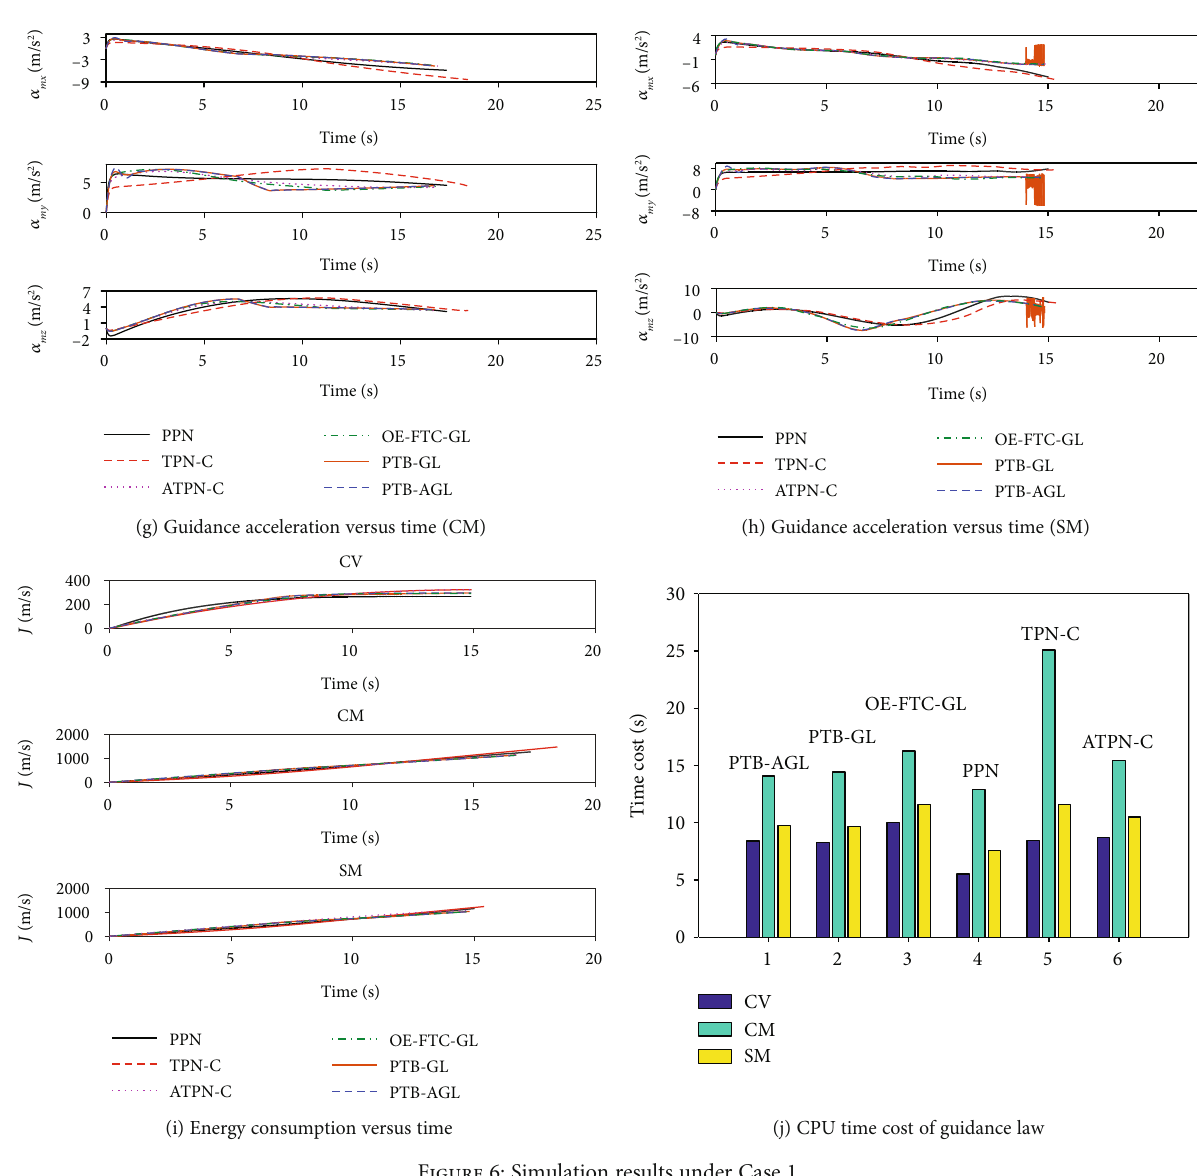
Figure 6: Simulation results under Case 1.